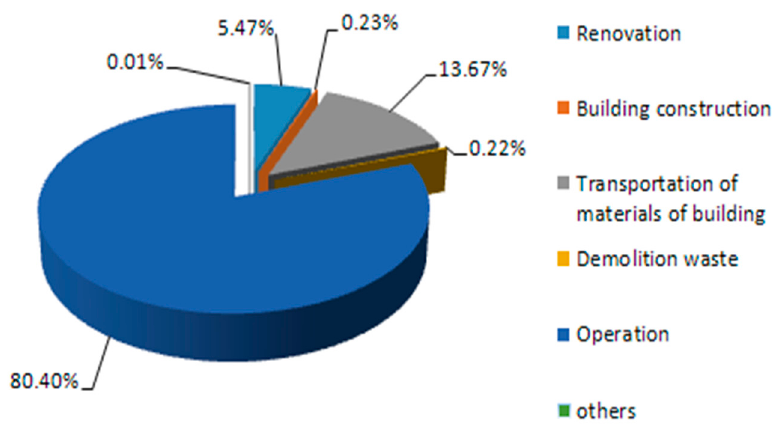
Figure 5. The proportion of energy consumption in the life of the building.